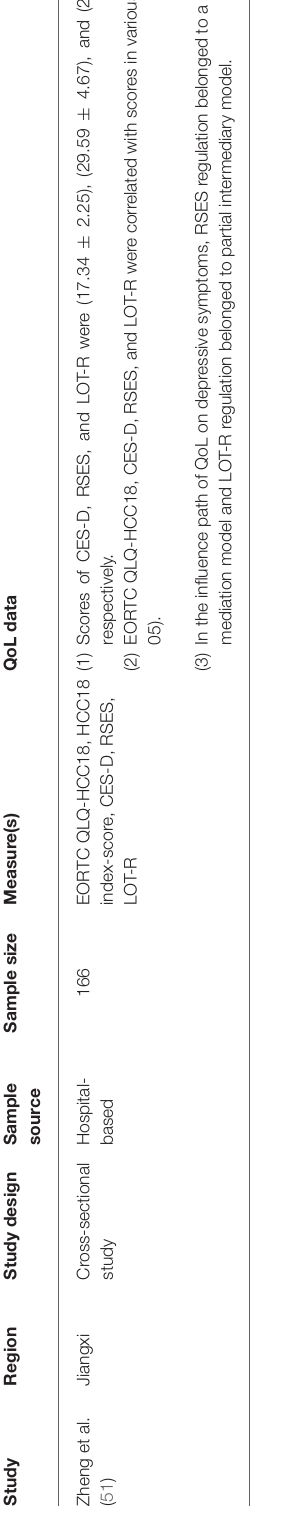
Pooled Norms, general data population a